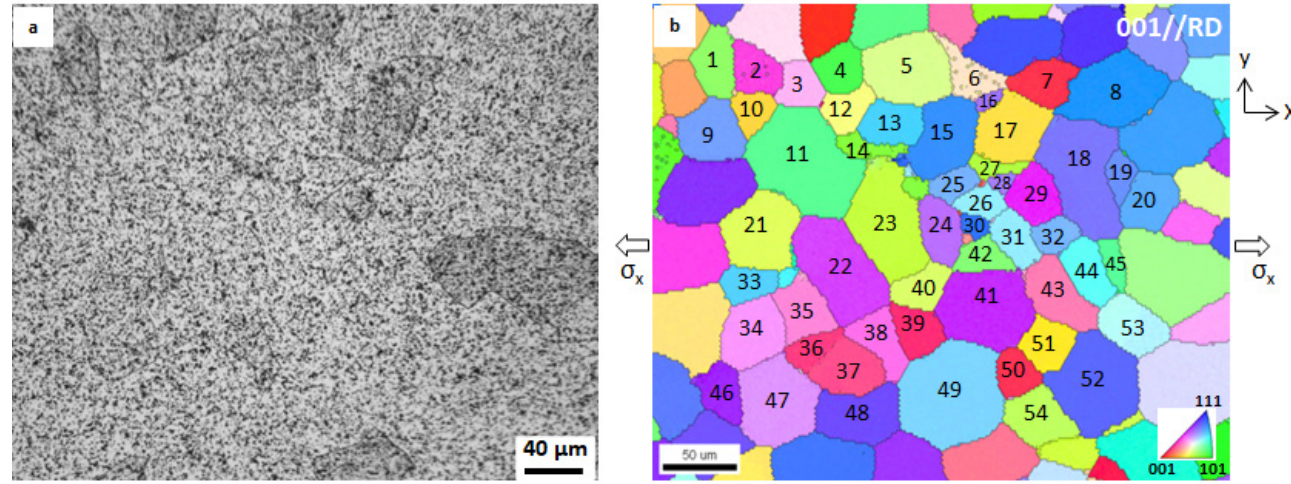
Figure 3. ( a ) Speckle on the etched front surface, ( b ) IPF (inverse pole figure) map corresponding to ( a ). The grains are numbered for digital image correlation (DIC). σ x , uniaxial remote stress.